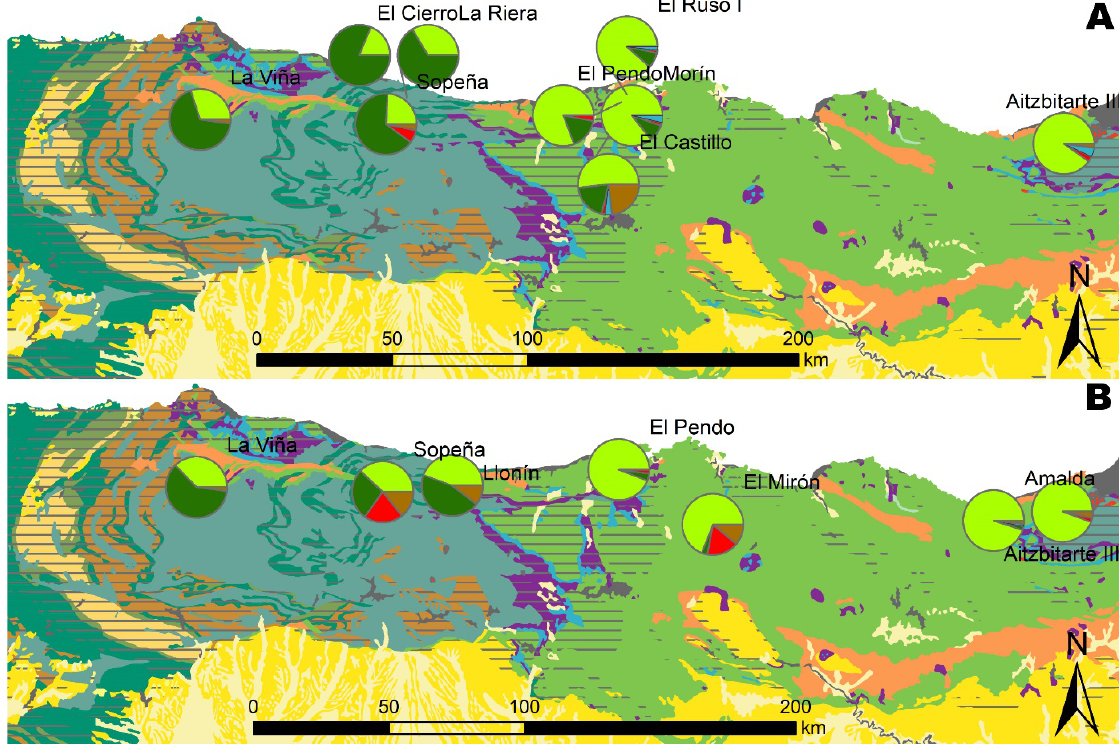
Figure 7. Raw material distribution at each archaeological site during the Aurignacian (above) and the Gravettian (below) using pie charts. Main chrono-lithological strata in the Cantabrian Region are displayed, based on a 1:1.000.000 geological map (Álvaro et al. 1994). Lithology colours are the same as for Figure 1. Pie chart colours are the same as in Figure